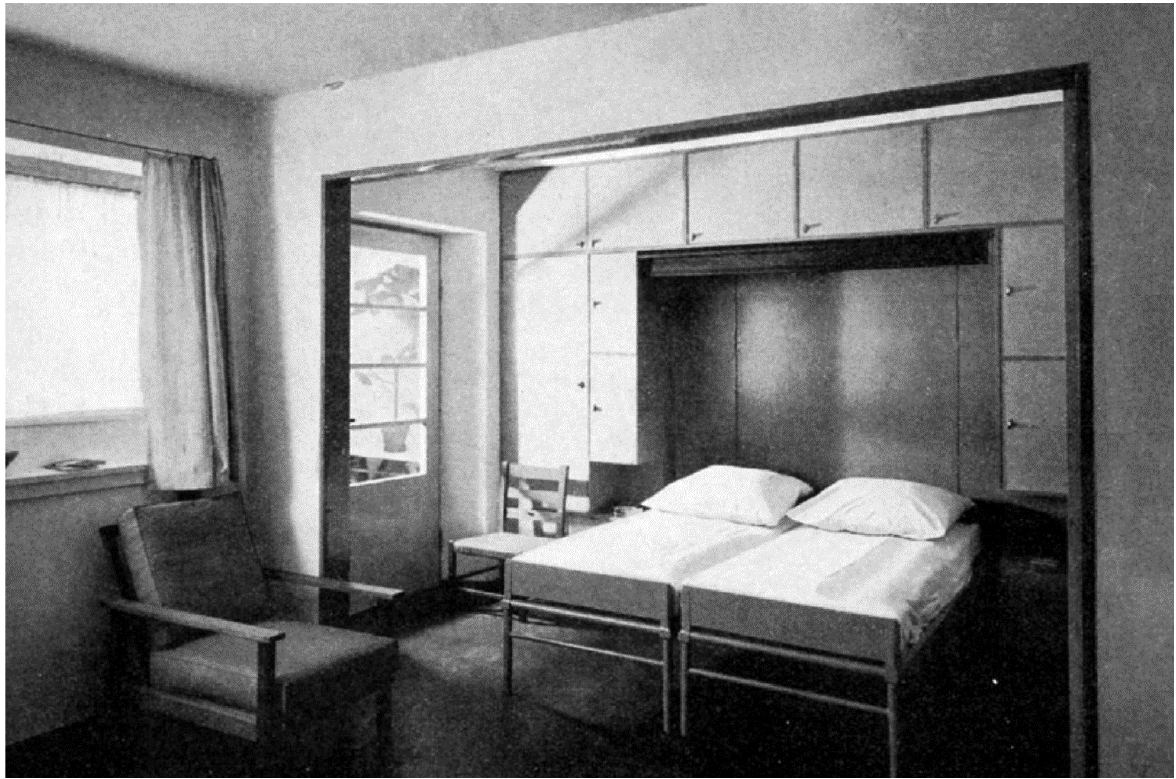
Figure 3. Ferdinand Kramer, housing in Frankfurt, beds in position in the living room. Source: Borngraeber (1978, p. 377). Urban Planning, 2019, Volume 4, Issue 3, Pages